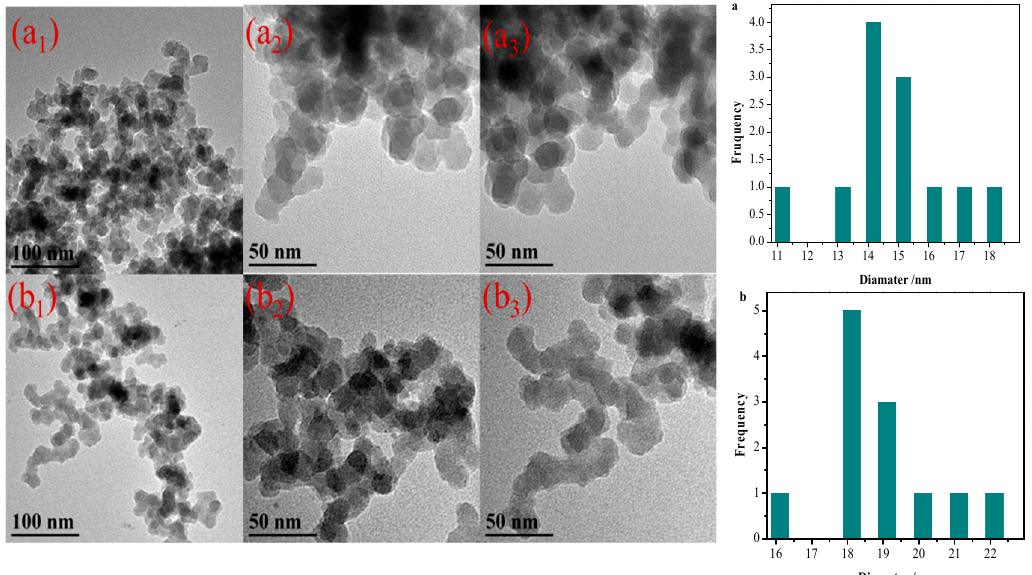
Figure 6. TEM images of ( a 1 - a 3 ) SNPs, ( b 1 - b 3 ) SNPs- g -PS and the particle size distribution.